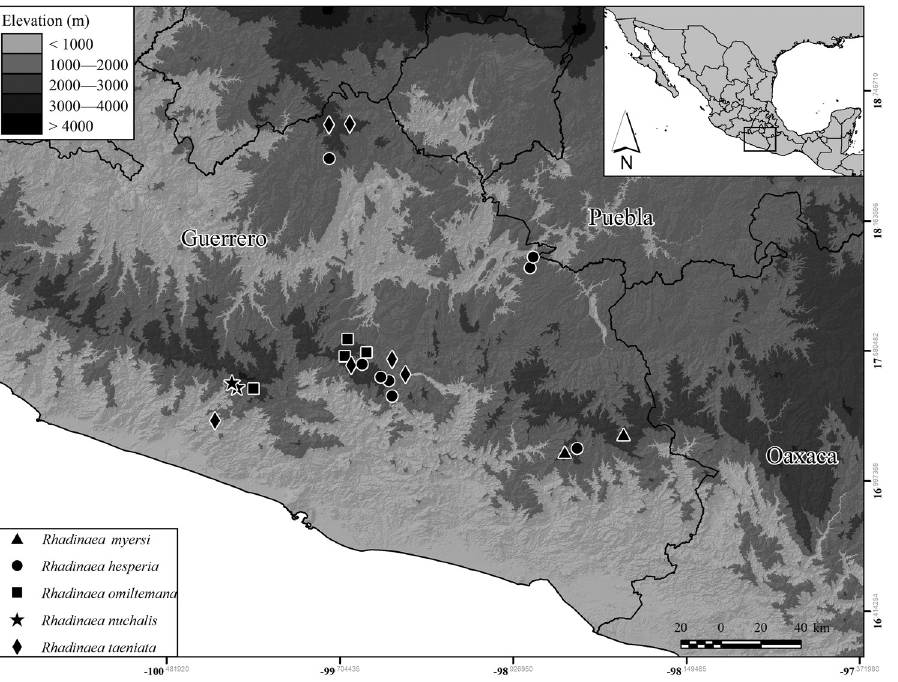
Figure 6. Collection localities of the species of the genus Rhadinaea in Guerrero. Black lines represent state